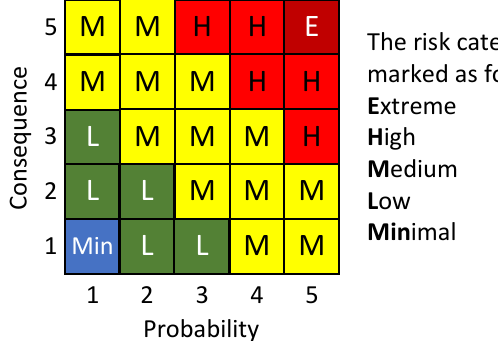
Figure 2. Risk matrix of the developed method.